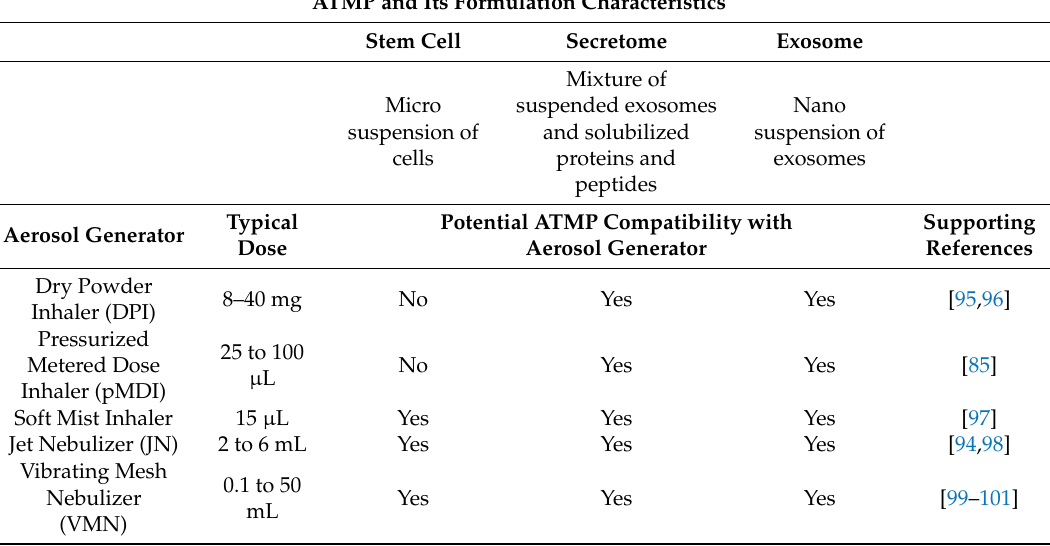
Table 1. Summary of Advanced Therapeutic Medicinal Product (ATMP) formulation characteristics and their compatibility with aerosol